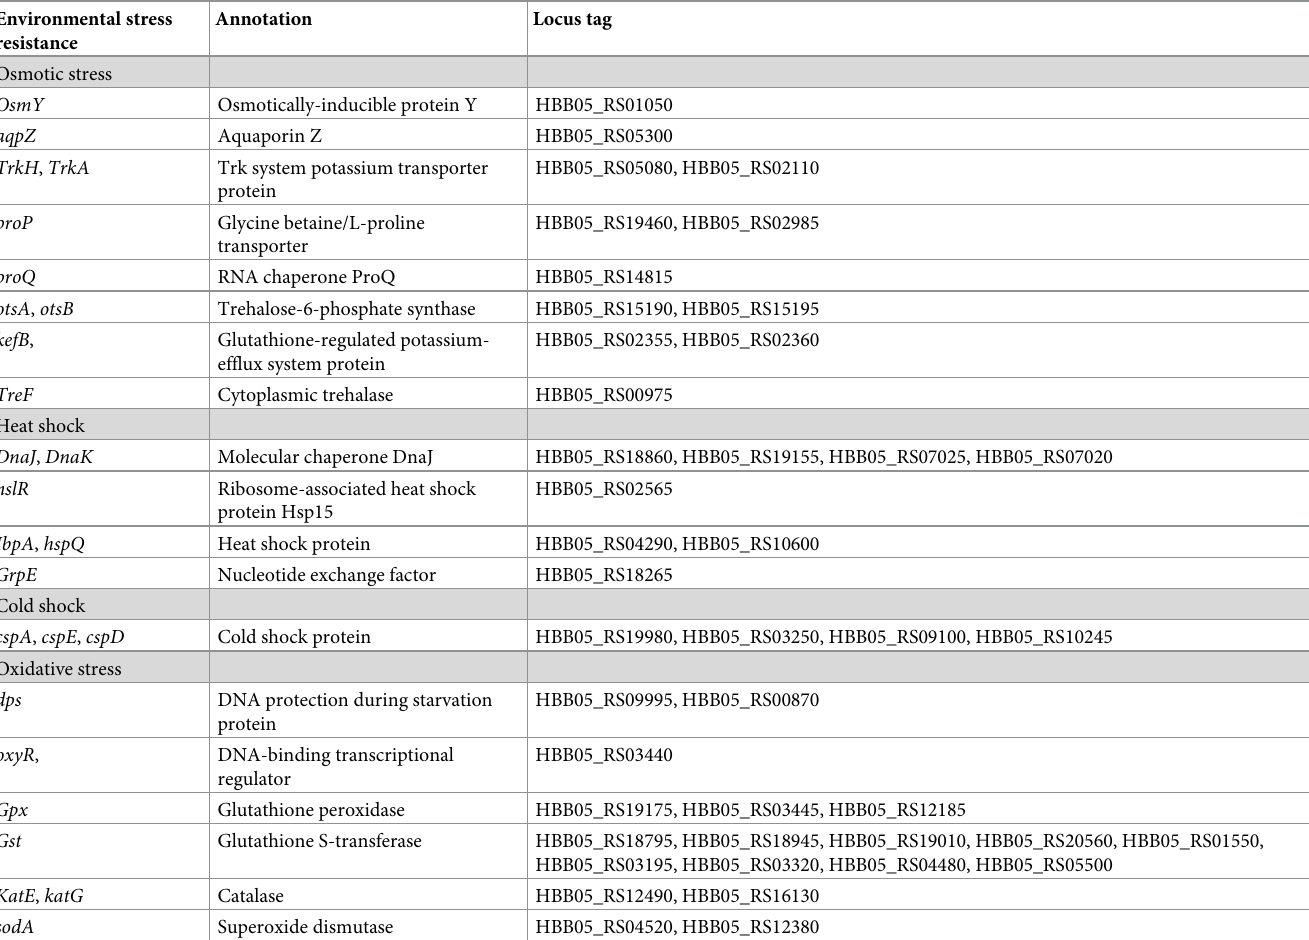
Table 2. Genes associated with resistance to environmental stress in P . agglomerans KM1. Environmental stress